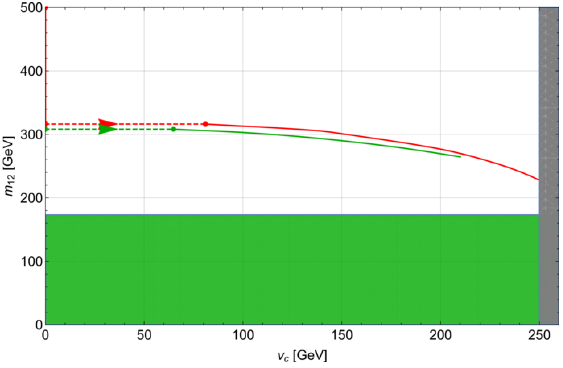
Figure 7 . The evolution of the critical vev v c as function of m 12 . The alignment limit and a common mass scale among the three BSM states M = 600 GeV are assumed. The dashed line with an arrow indicates the jump from the second order PT to the (cid:12)rst order PT. Red and green curves represent tan (cid:12) = 1 and 1 : 5, respectively and terminate at which a proper EWSB at one loop level does not happen at zero temperature. In the gray-shaded region v c exceeds the EW vacuum v = 246 GeV and in the green-shade region at least one of the (cid:21) ’s (mostly j (cid:21) 1 j or j (cid:21) 2 j ) exceeds